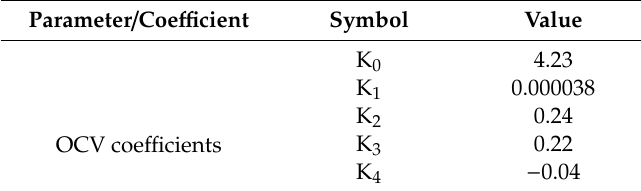
Table 4. RC ECM Li-ion battery open-circuit controlled voltage (OCV) coe ffi